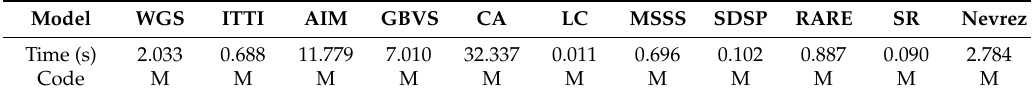
Table 1. Comparisons of the computational time.